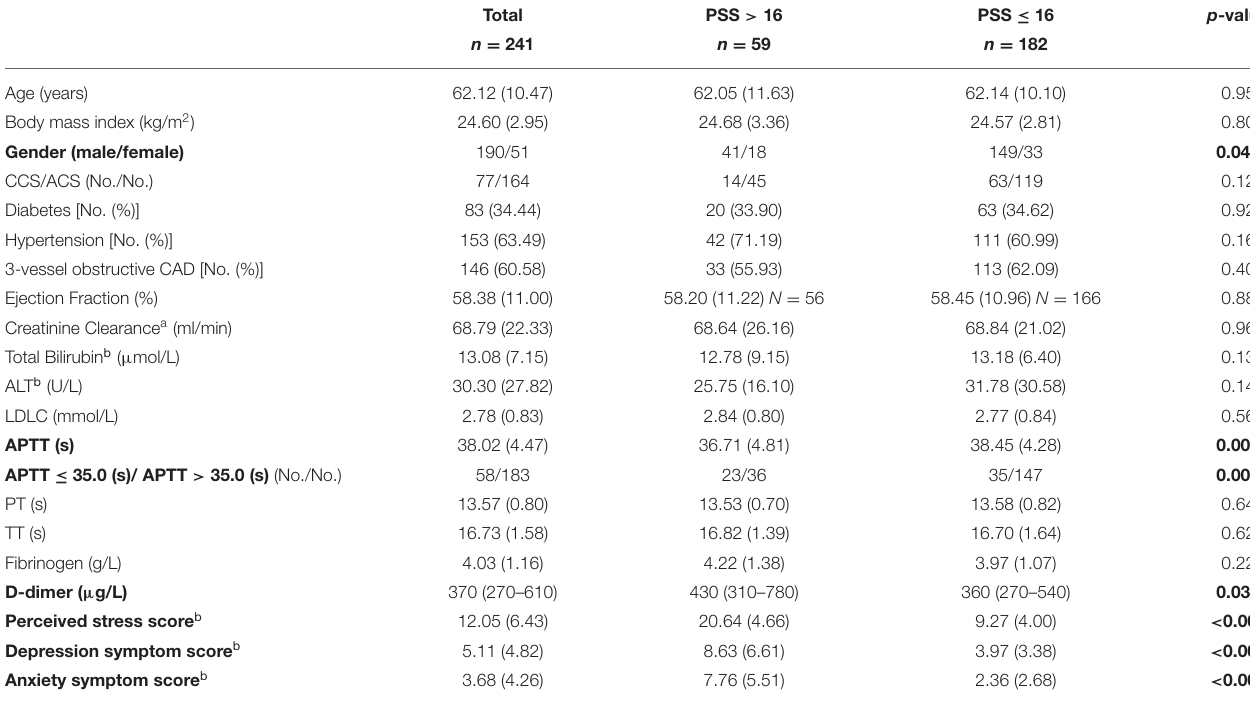
TABLE 1 | Comparisons of the baseline characteristics between the groups categorized by perceived stress